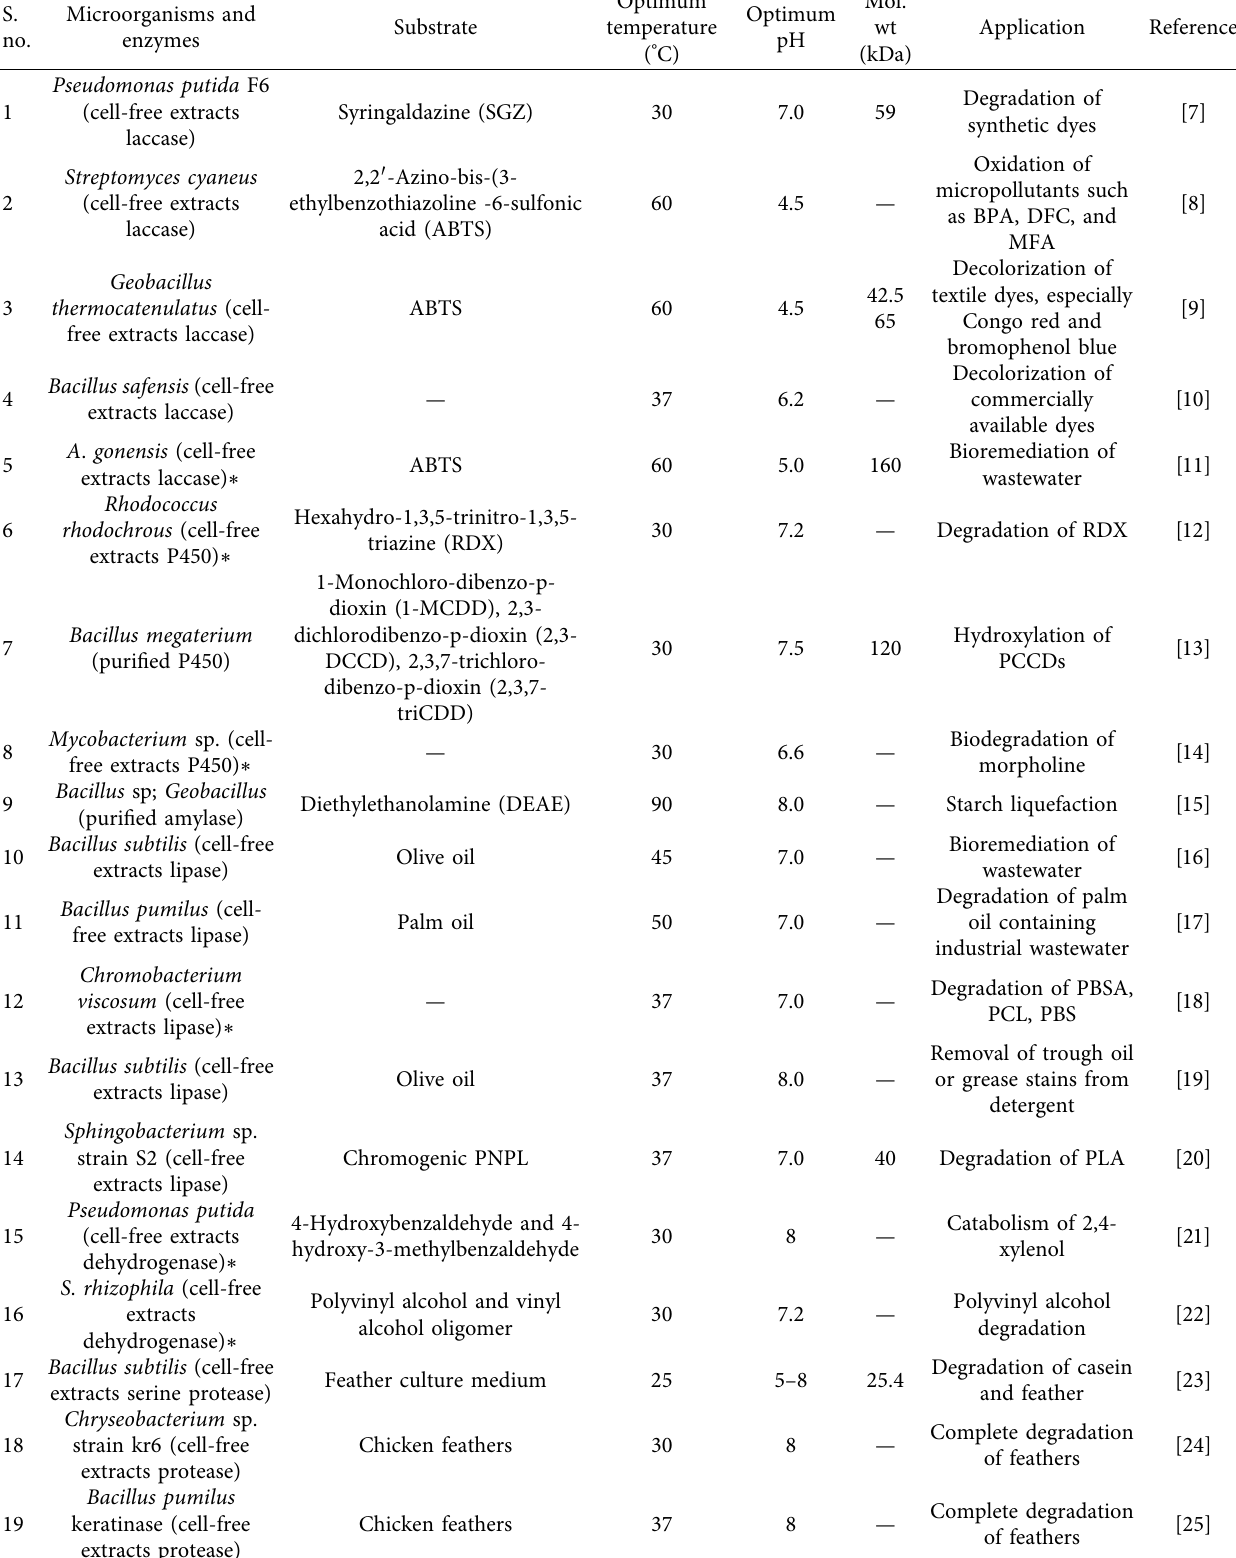
Table 1: Properties and applications of various microbial enzymes from different microorganisms.